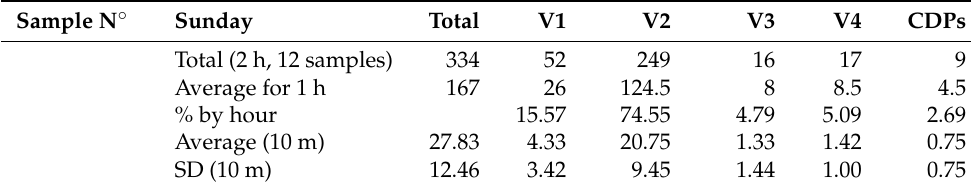
Table 5. Sunday sample resume.